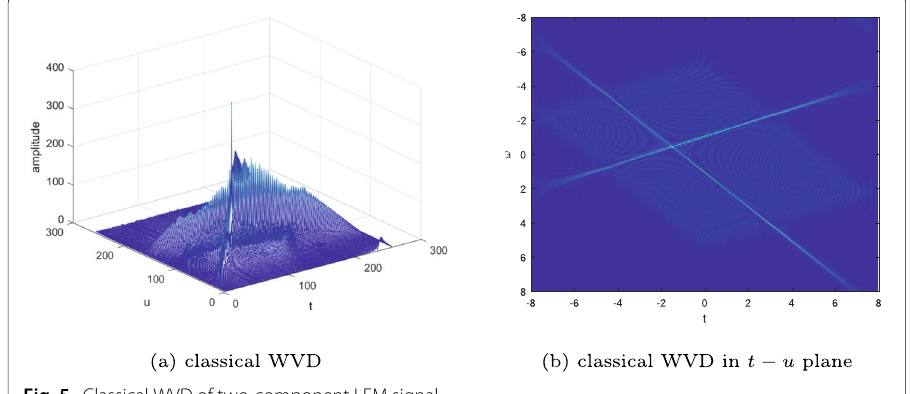
Fig. 5 Classical WVD of two-component LFM